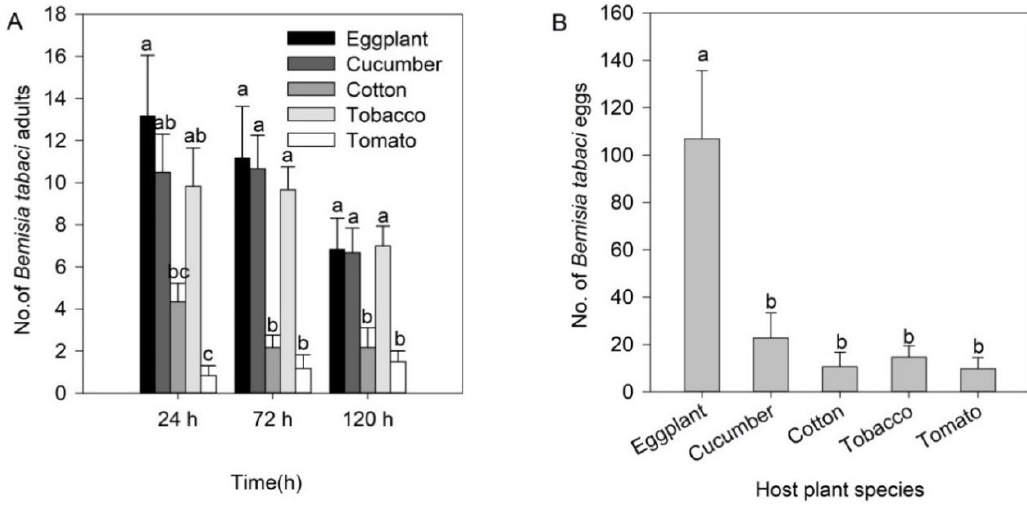
Figure 1. Numbers (mean ± SE) of Bemisia tabaci adults ( A ) and eggs after adults had infested plants for 120 h ( B ) for each plant in greenhouse cage experiments. Different lowercase letters mean significant differences among plant species at the same time at p < 0.05.